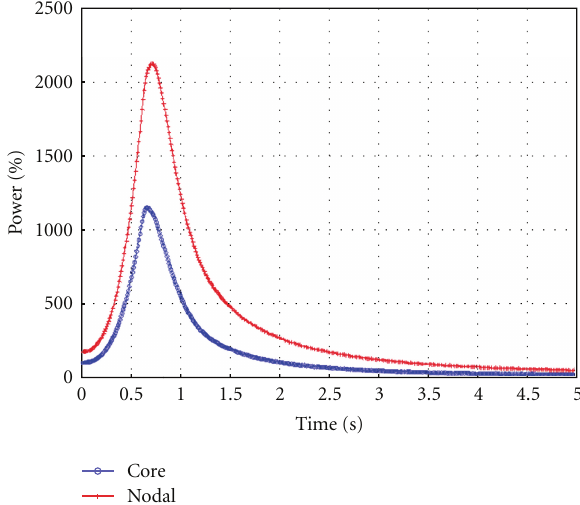
Figure 20: Transient: core and peak nodal power versus time.